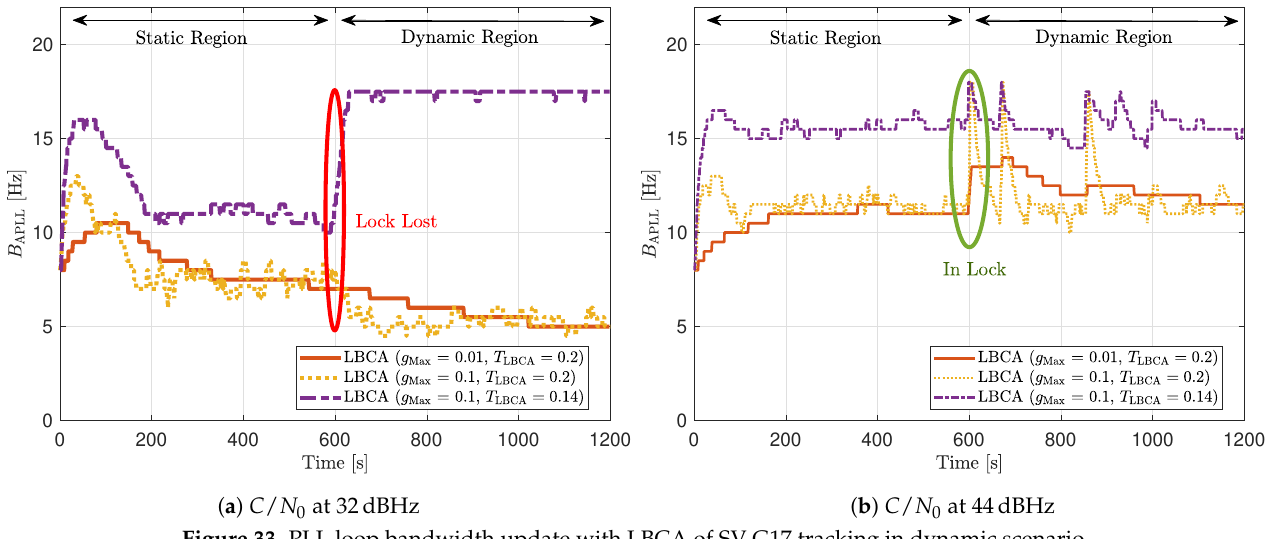
Figure 33. PLL loop bandwidth update with LBCA of SV G17 tracking in dynamic scenario. The LBCA with PLAN interpolation presents a similar dynamic performance as the LBCA at high C / N 0 levels (see Figure 34). At lower C / N 0 , the dynamic performance using a scale factor of g Max = 0.1 and a normalized dynamics threshold T LBCA = 0.14 stands out above the rest of the configurations. This configuration maintains the lock even at 32 dBHz. In addition, the configuration with g Max = 0.1 and T LBCA = 0.2 has poor tracking performance at 44 dBHz. However, the system performance is similar to the other configurations at that C / N 0 level.